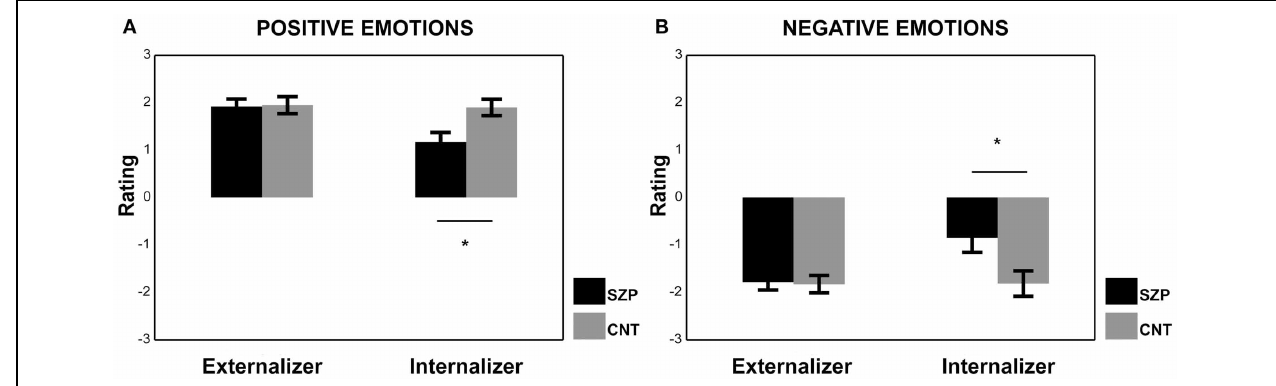
FIGURE 5 | Mean rating scores of Externalizer and Internalizer cohorts during the presentation of Positive (A) and Negative (B) emotions. Asterisks represent significant differences between SZP and CNT. All other conventions as in Figure 3